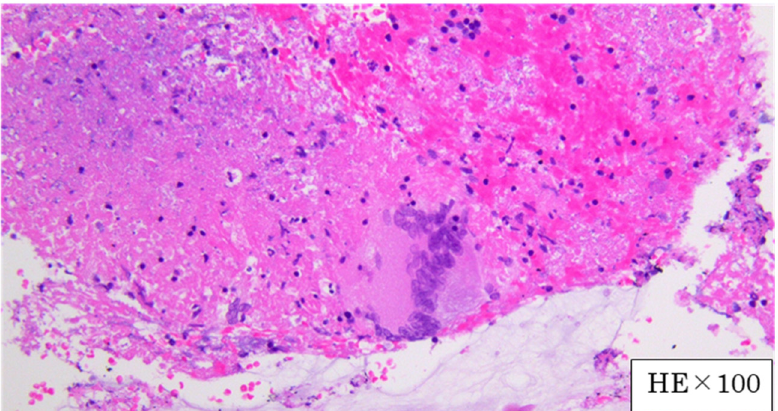
Figure 4. Histological findings of a lymph node obtained with EBUS-TBNA demonstrated epidermoid cell granulomas with Langerhans’ giant cells.